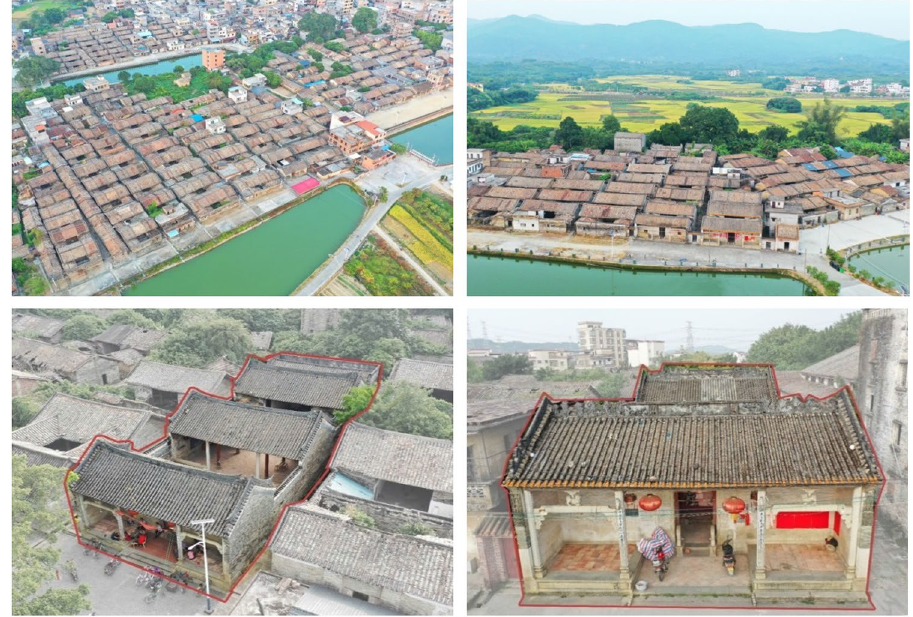
Fig.1 Traditional villages and ancient buildings in Conghua